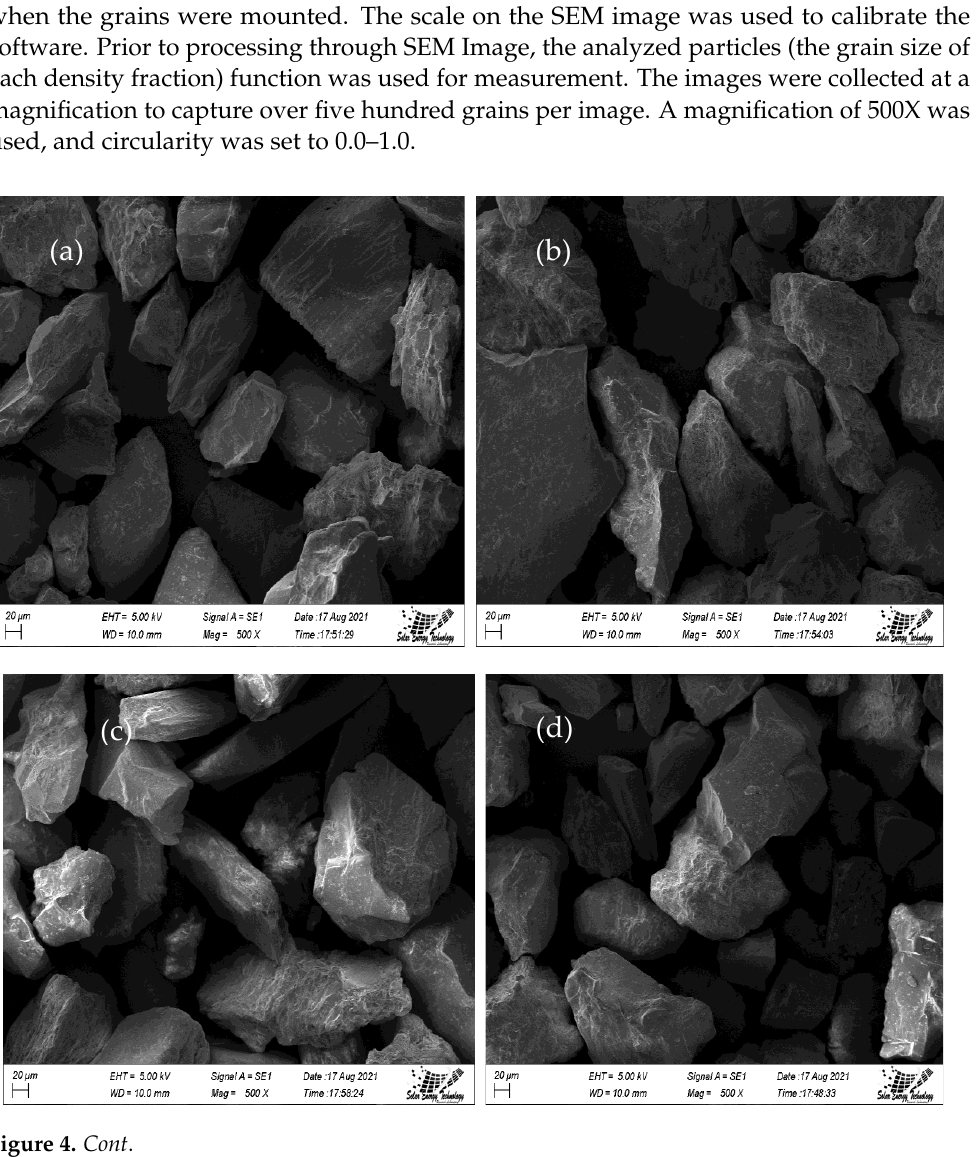
Figure 4. (a – e). SEM images of Nijhum Dwip, Domar Char, Nimtoli, Qazir Bazar and Rahmat Bazar grains, respectively; scale bar = 20 µm.